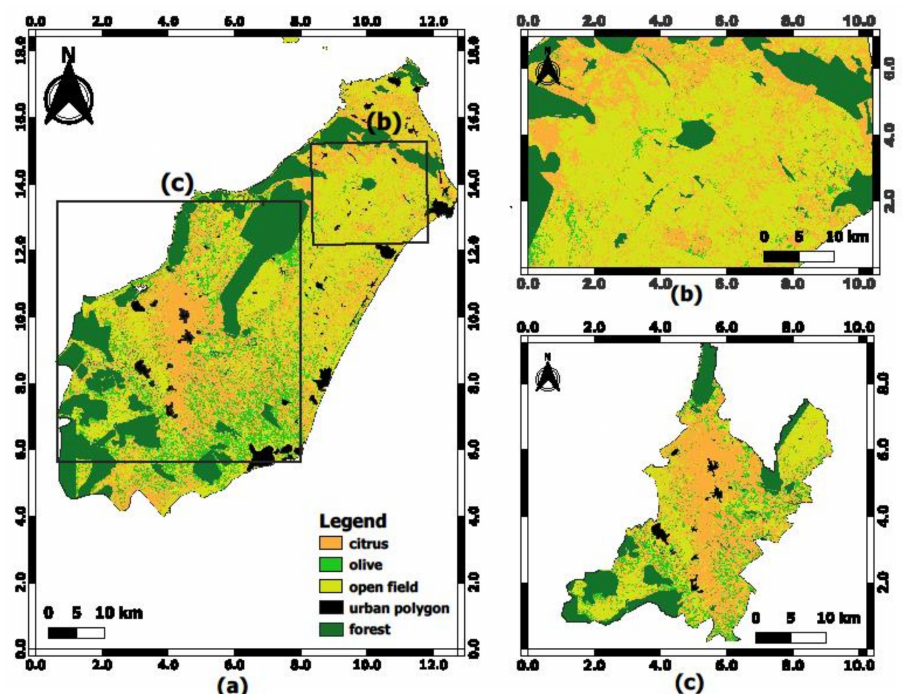
Figure 8. ( a ) Visualization of the classification results with the M10 classifier within the first scenario (NDVI) at the level of the whole Cap Bon region; ( b ) zoom on the area marked by the ( b ) square located in northeast of the region; and ( c ) zoom on the area marked by the ( c ) square located in southwest of the region.